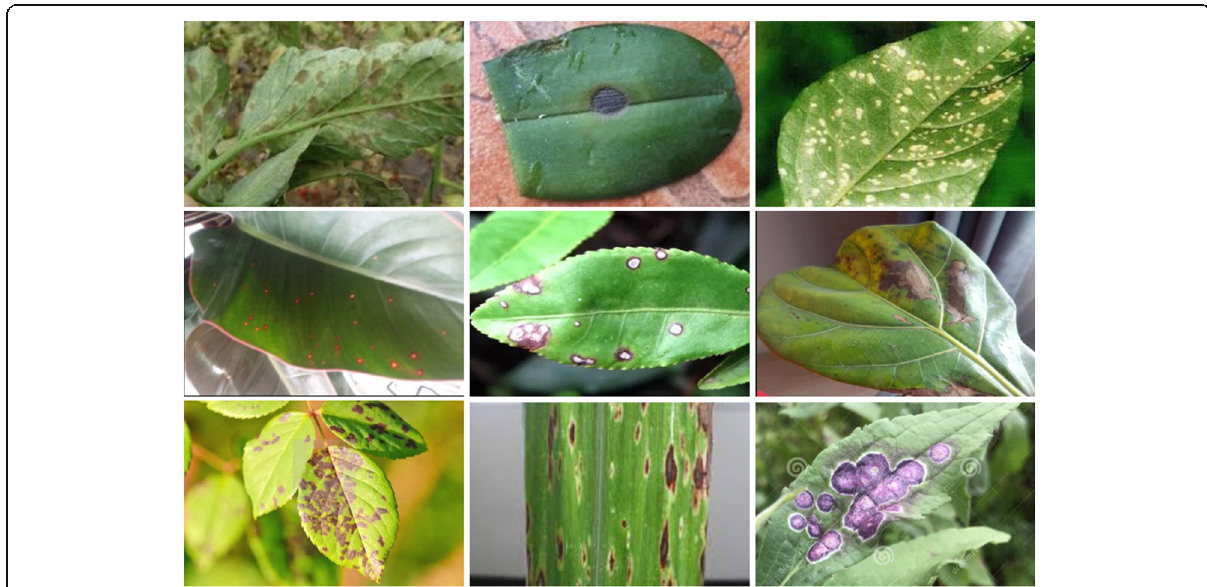
Fig. 4 The representative of diseases and pests affecting tomato plants. In Fig. 4, we show representatives of different conditions and varying diseases and pests identified in our work. ( a ) gray mold, ( b ) canker, ( c ) leaf mildew, ( d ) plague Yersinia pestis, ( e ) leaf miner, ( f ) whitefly, ( g ) low temperature, ( h ) nutrition excess or lack of, ( i ) powdery mildew. Collect images under different changing and environmental conditions. These patterns help to distinguish between certain appropriate characteristics of each disease and